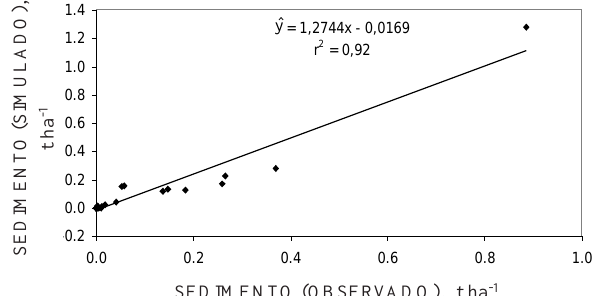
Figura 3. Diagrama de dispersão entre a produção de sedimentos observada e a simulada, para a MHRM.